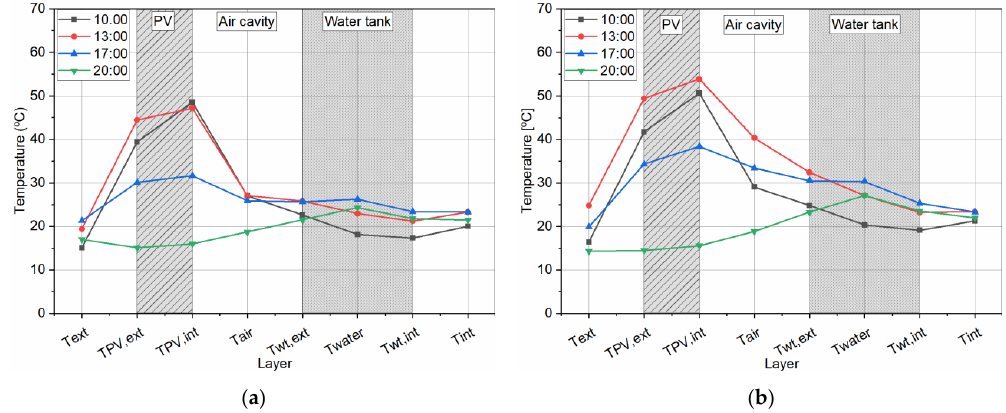
Figure 7. BIPV-WS thermal behavior: ( a ) February 21st, ventilated air cavity; ( b ) February 24th, non-ventilated air cavity. During the day, the water tank temperature presented temperatures between 16.8 °C and 26.3 °C for the ventilated air cavity, and 18.9 °C and 30.5 °C for the non-ventilated air cavity. On the other hand, it can be observed that the maximum temperature difference between the external and internal water tank surfaces was about 6.6 °C for the ventilated scenario and 9.6 °C for the non-ventilated scenario. In the ventilated scenario, the air circulated between the indoor thermal zone and the BIPV-WS thermal zone through the opening of interior vents and free air circulation. In this scenario, the interior vents were opened at 10:42 h and closed at 18:00 h. The ventilation of the air cavity effects can be observed in the temperature profile of the air cavity and water temperature. In Figure 8, these temperatures are presented for both ventilated and non-ventilated air cavities. Regarding the behavior of an air cavity, it can easily be observed that the temperature dropped down after opening the interior vents and ventilation was started, compared with the non-ventilated scenario, where the temperature inside the closed cavity continu- ously rose. The difference of maximum values of the temperature inside the air cavity was about 14 °C at the peak radiation hour between the ventilated and non-ventilated scenar- ios, demonstrating the ventilation effect in the air cavity temperature. Moreover, observ- ing the water temperature profile, it can also be observed that the difference between the maximum values in the ventilated and non-ventilated air cavities was about 5 °C. ( a )